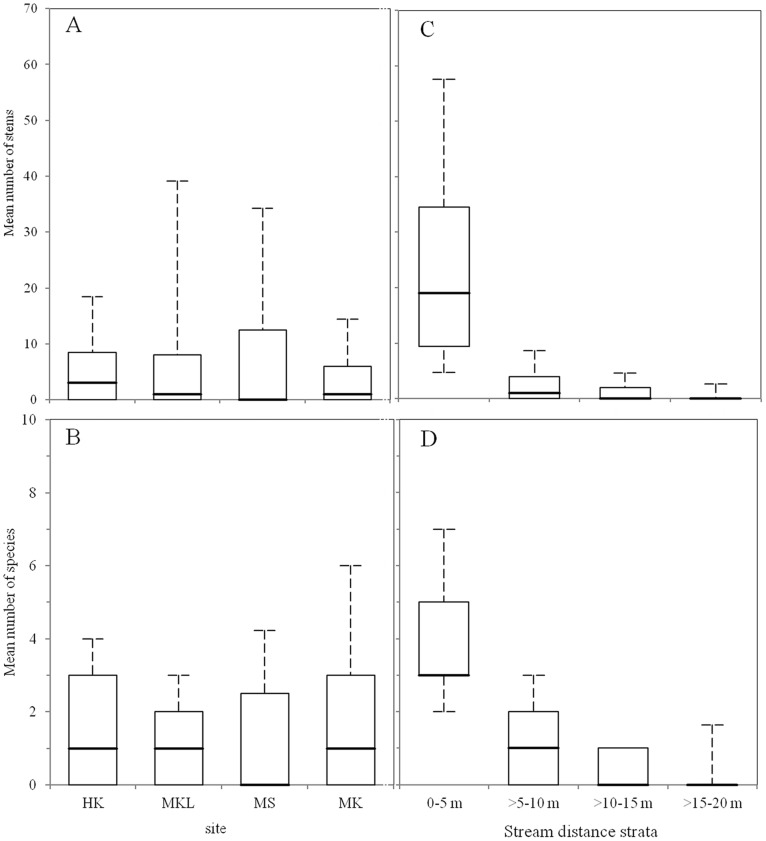
Mean number of stems (A, C) and mean number of species (B, D) in four stream sites (left) and at each stream distance stratum (right).The boxplots describe the relationship between mean number of stems and species richness in each stream and stream distance strata. The maximum and minimum extents of the boxes indicate 25th and 75th percentiles and thick solid lines indicate the medians.